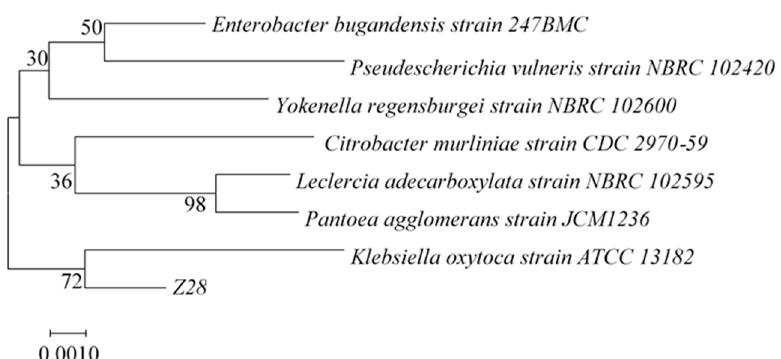
Figure 2. Identification of strains Z28 by 16 S rRNA sequencing after constructing the phylogenetic tree using the neighbor-joining method at 500 replicates of bootstrap value.